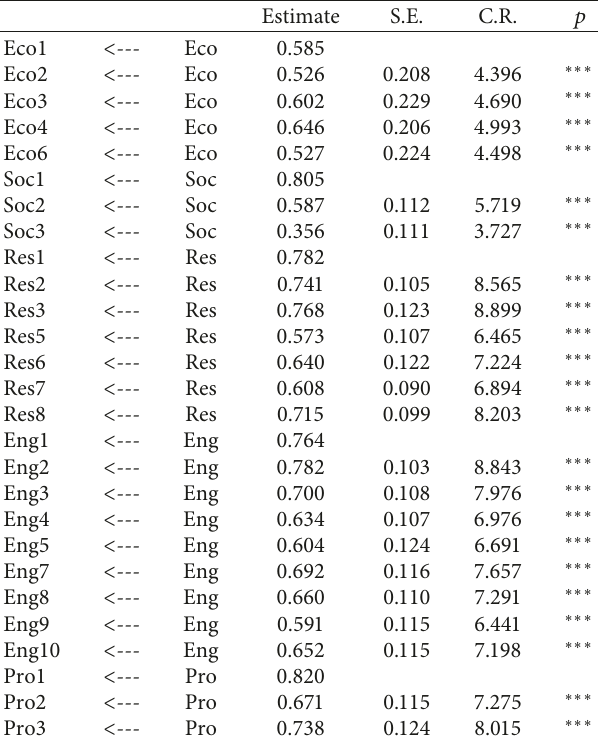
Table 8: Weight of the indicators. Dimension Indicators